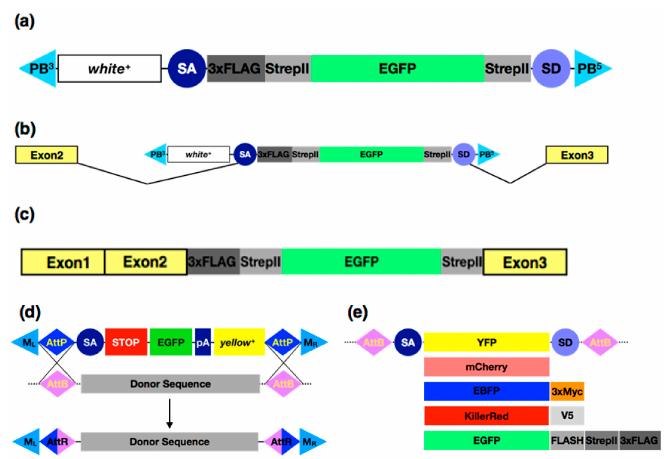
Figure 2. Protein Trapping. ( a – c ) piggyBac transposon-based protein trapping . ( a ) The pigP protein trap element used in [47]: the transposon ends (blue triangles) flank a genetic marker gene ( white ) and an artificial exon, which in this case contains the coding sequence for enhanced green fluorescent protein (EGFP) along with StrepII and 3XFLAG tags between splice donor and splice acceptor sites (blue circles). ( b ) Insertion of the transposon into an intron of a protein coding gene (represented by lines separating the yellow boxes) allows the possibility of splicing the artificial exon into the gene transcript. ( c ) If the transcript carrying the artificial exon is translated a tagged protein is generated. ( d , e ) The Minos-mediated integration cassette (MiMIC) System. ( d ) A Minos -based transposon with transposable element (TE) ends indicated by blue triangles, contains two attP sites in inverted orientation (blue diamonds) flanking a gene trap cassette with a splice acceptor (blue circle), stop codons in all three reading frames (red box), a fluorescent marker (EGFP) followed by a polyadenylation signal (blue box) and a genetic marker ( yellow ) . The sequences internal to the attP sites may be replaced via a RMCE reaction by providing a donor sequence flanked by attB sites and a source of phiC31 integrase. ( e ) A variety of different fluorescent reporters have been developed that can be used to introduce tags into genes with MiMIC insertions in coding introns via